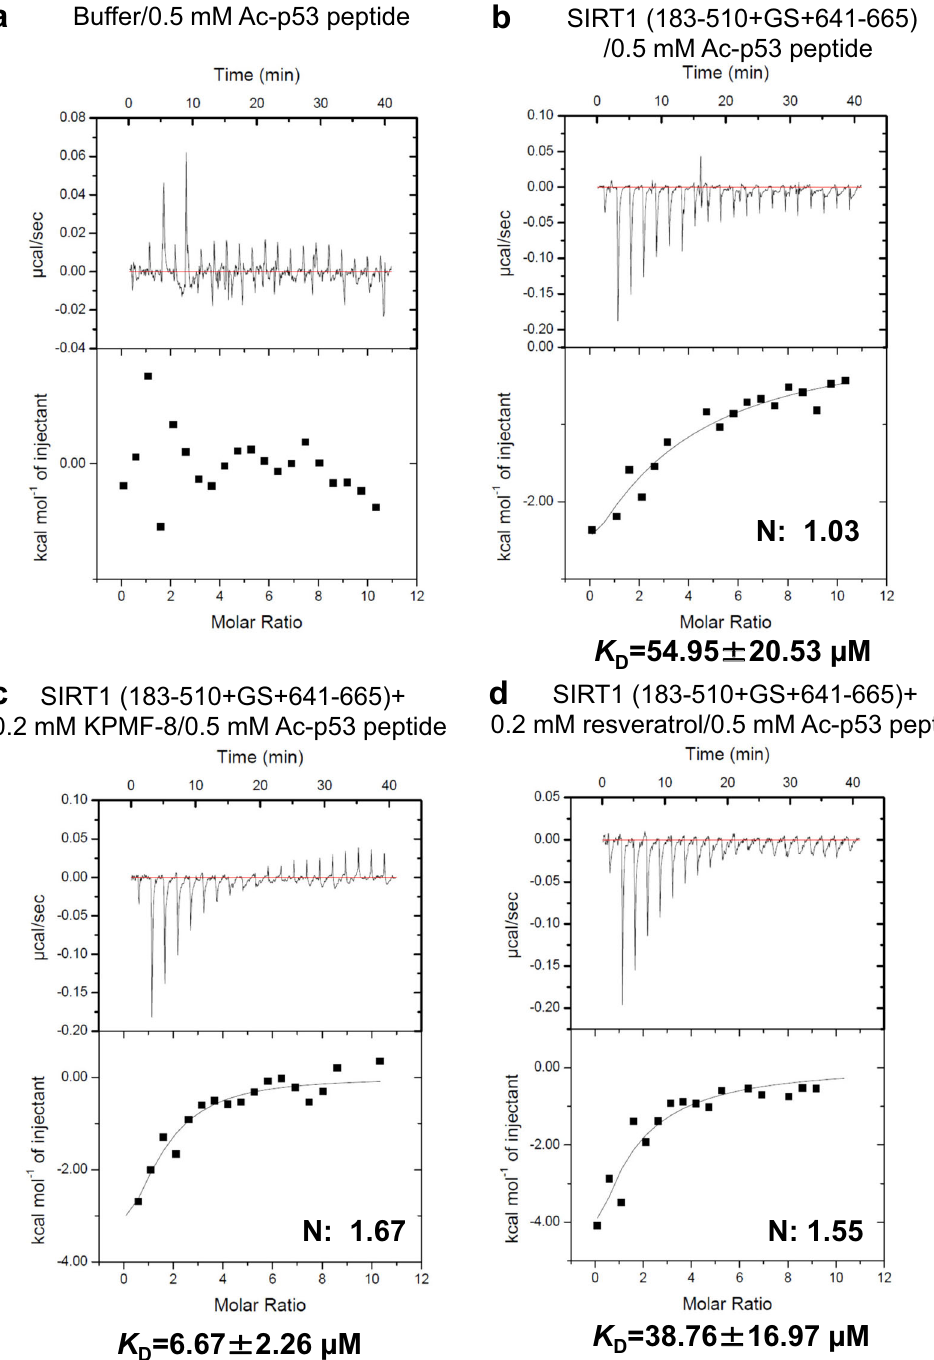
Fig. 4 Binding of Ac-p53 peptide to SIRT1 determined using ITC. a Titration of Ac-p53 peptide to the buffer for SIRT1 (183 – 510 + GS + 641 – 665). Binding of Ac-p53 peptide b to SIRT1 (183 – 510 + GS + 641 – 665), c to SIRT1 (183 – 510 + GS + 641 – 665) in the presence of 0.2 mM KPMF-8, and d to SIRT1 (183 – 510 + GS + 641 – 665) in the presence of 0.2 mM resveratrol. K D values ± curve- fi t errors are indicated underneath each